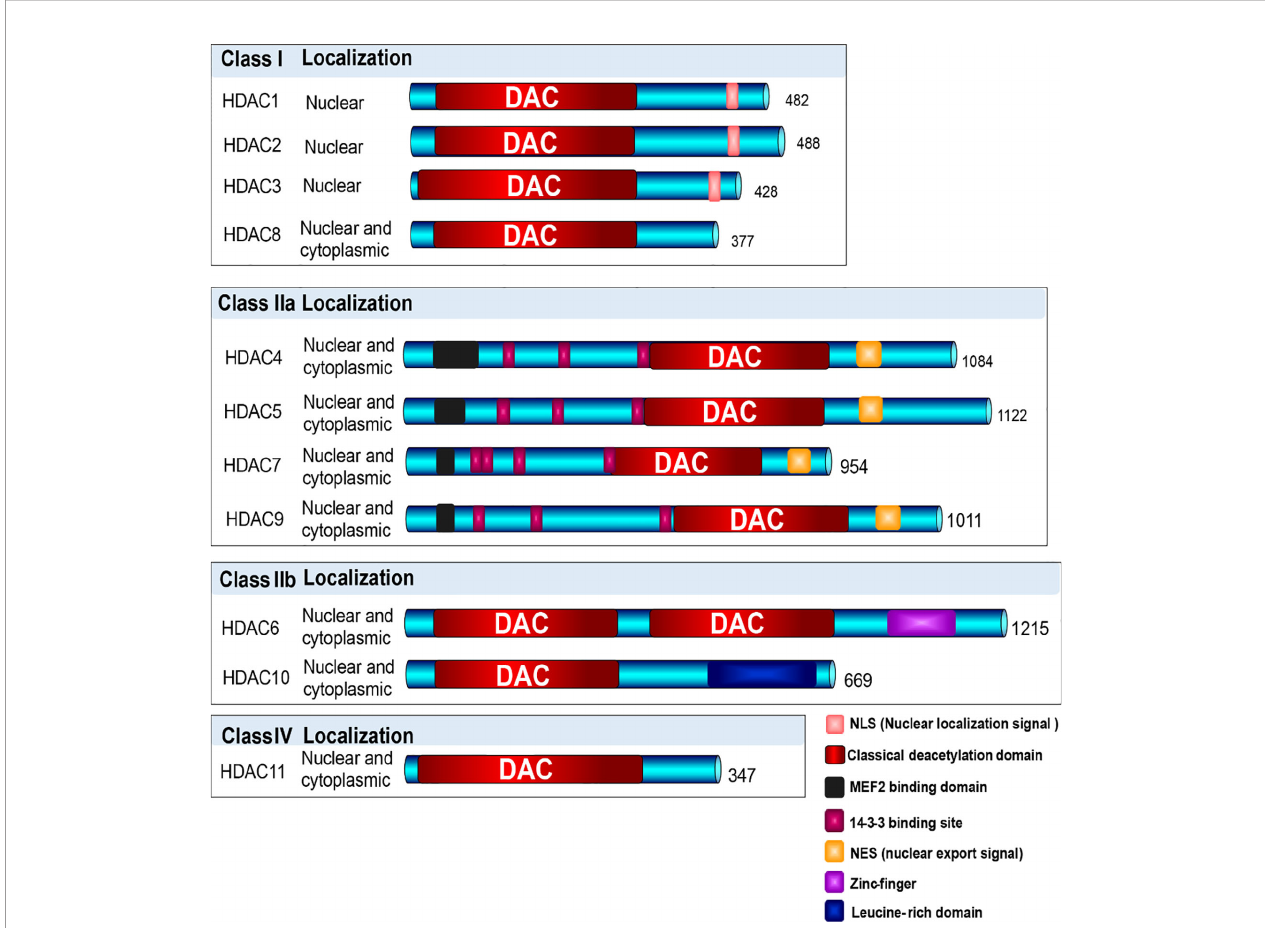
FIGURE 3 | Classi fi cation of HDACs. Based on the phylogenetic analysis, sequence homology to yeast protein, and domain organization, HDAC enzymes are categorized into four families (class I, IIa, IIb, III and IV). Three of them contain the Zn 2+ dependent catalytic domain, which are referred to as classical HDACs, and class III members are NAD + -dependent, which were not involved in this description. Class I HDACs contains HDAC1, 2, 3, and 8, which majorly localize in nuclear; Class II HDACs include Class IIa (HDAC4, 5, 7, 9) and Class IIb (HDAC6, 10), which shuttle between nuclear and cytoplasm; and Class IV contains only HDAC11, shuttling between nuclear and